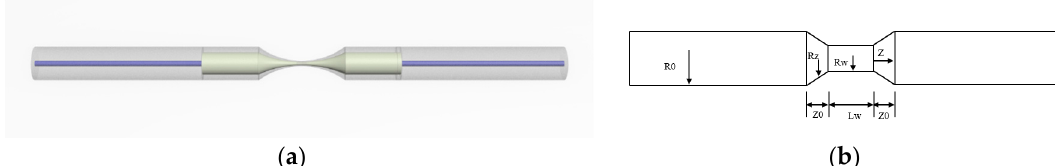
Figure 4. ( a ) Schematic diagram; ( b ) illustration of a STMS fiber structure [27].